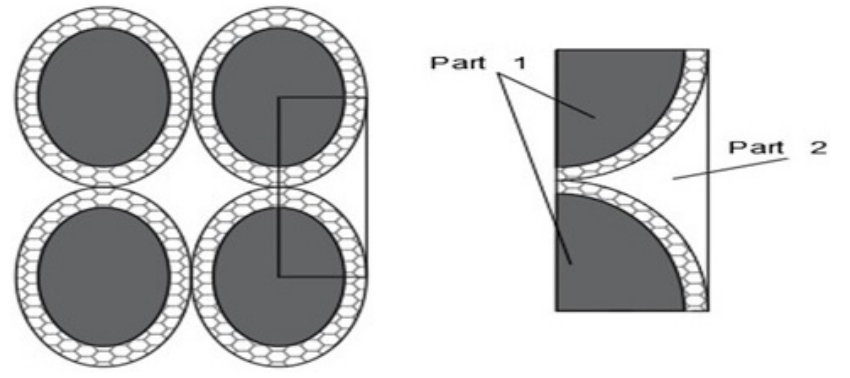
Figure 1. 2D Reticular Cluster, Feng [23].